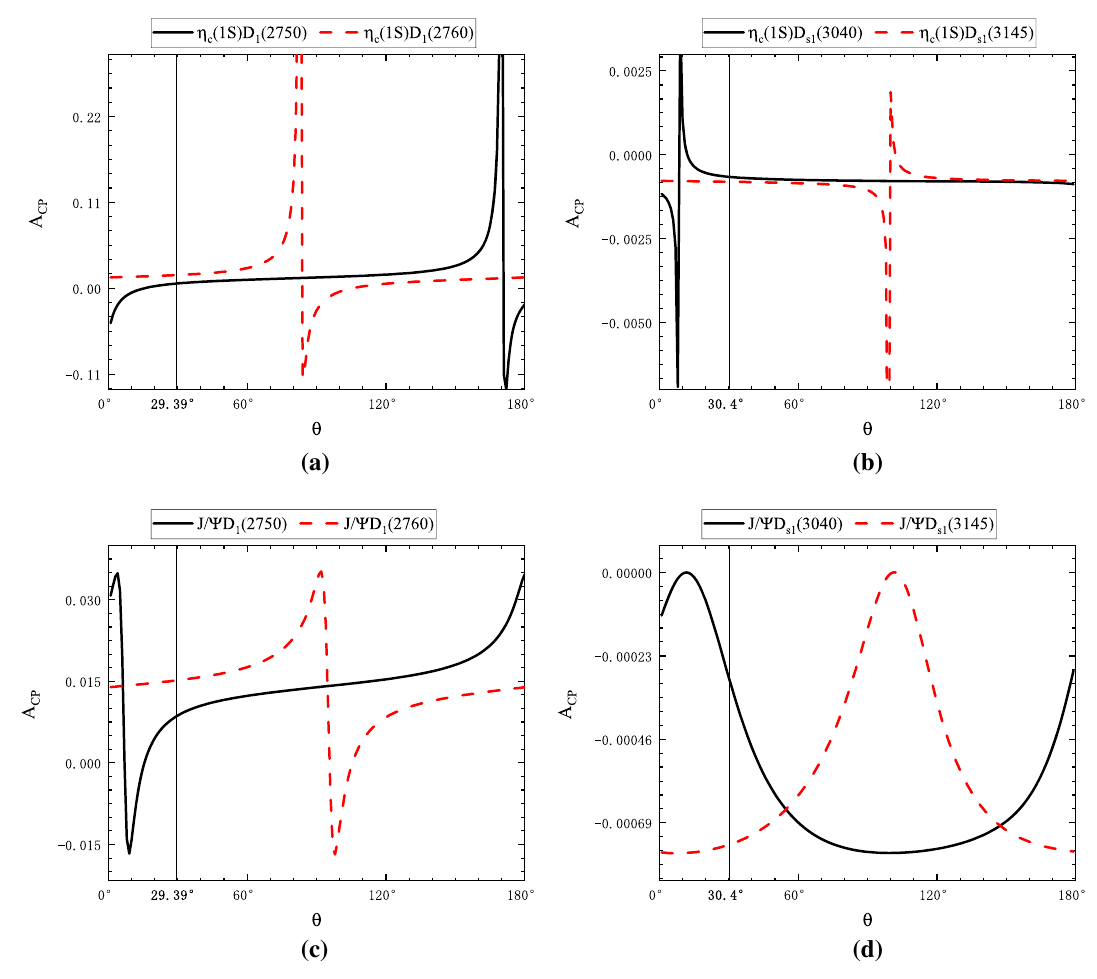
Fig. 11 A cp varies along with the mixing angle for the B c → c ¯ c ( 1 S ) + D ( s ) 1 ( 2 P )